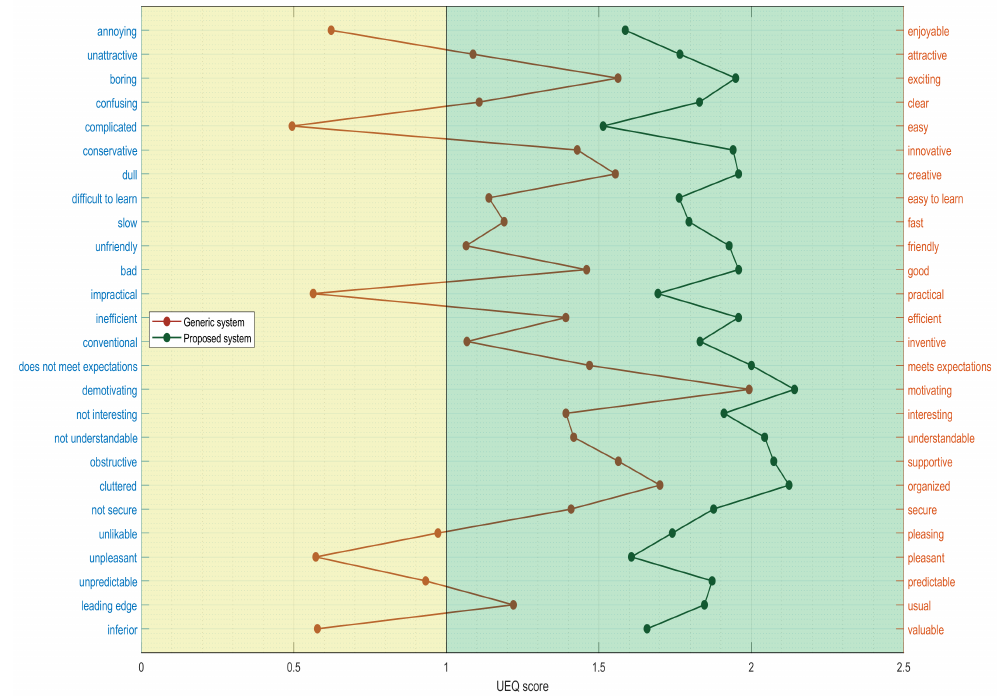
Figure 21. The results of UEQ